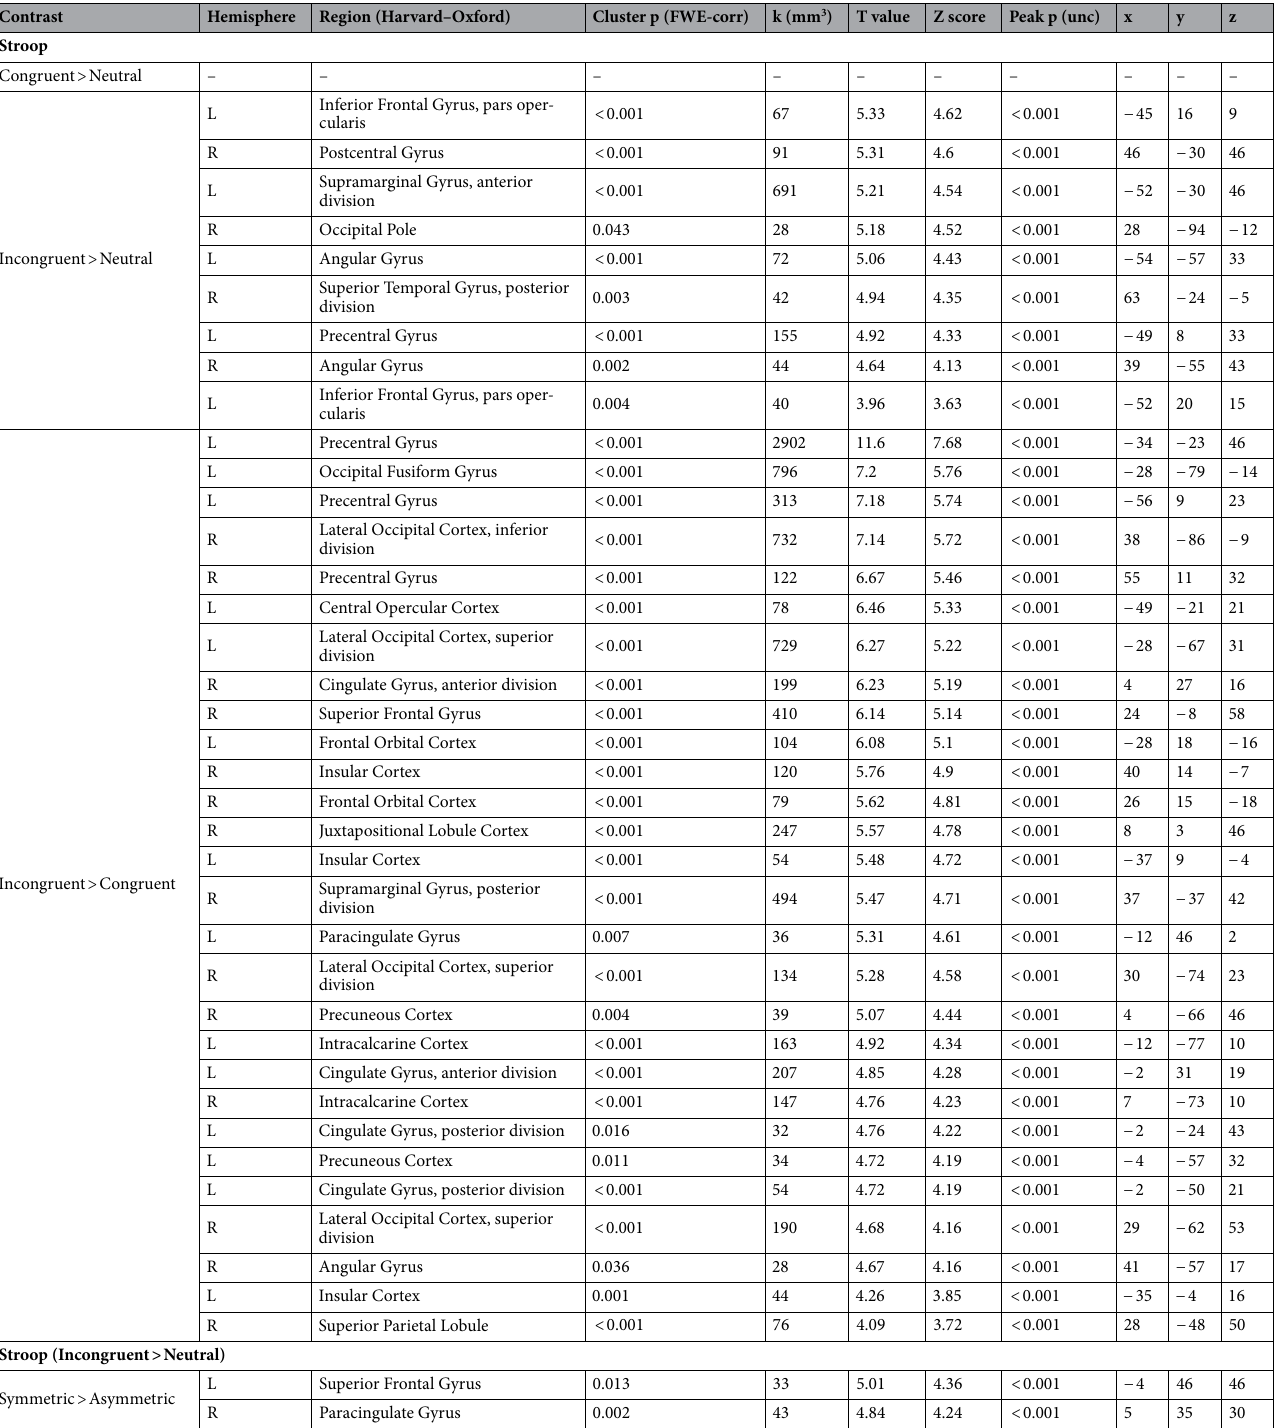
Table 2. t-contrast results for the effects detected in the Numerical Stroop task. Group differences between individuals with symmetric and asymmetric ACC sulcation patterns are also reported. Significance threshold is set at vertex-p-uncorrected < 0.001 and cluster-p-FWE-corrected < 0.05. Only one local maximum per significant cluster is listed. R Right hemisphere, L Left